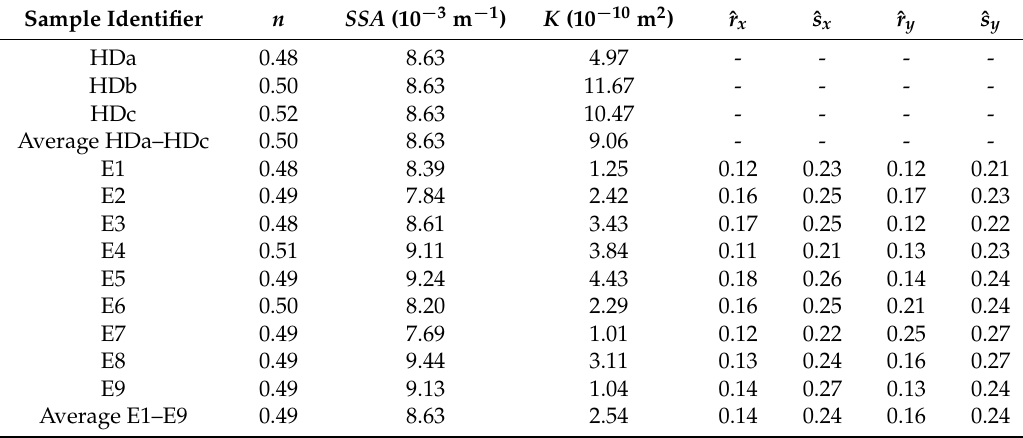
Table 1. Connected porosity ( n ), Specific Surface Area (SSA), intrinsic permeability ( K ) and maximum likelihood (ML) estimates of range and sill (ˆ r i and ˆ s i ; i = x , y ) of directional variograms of the indicator function of the pore